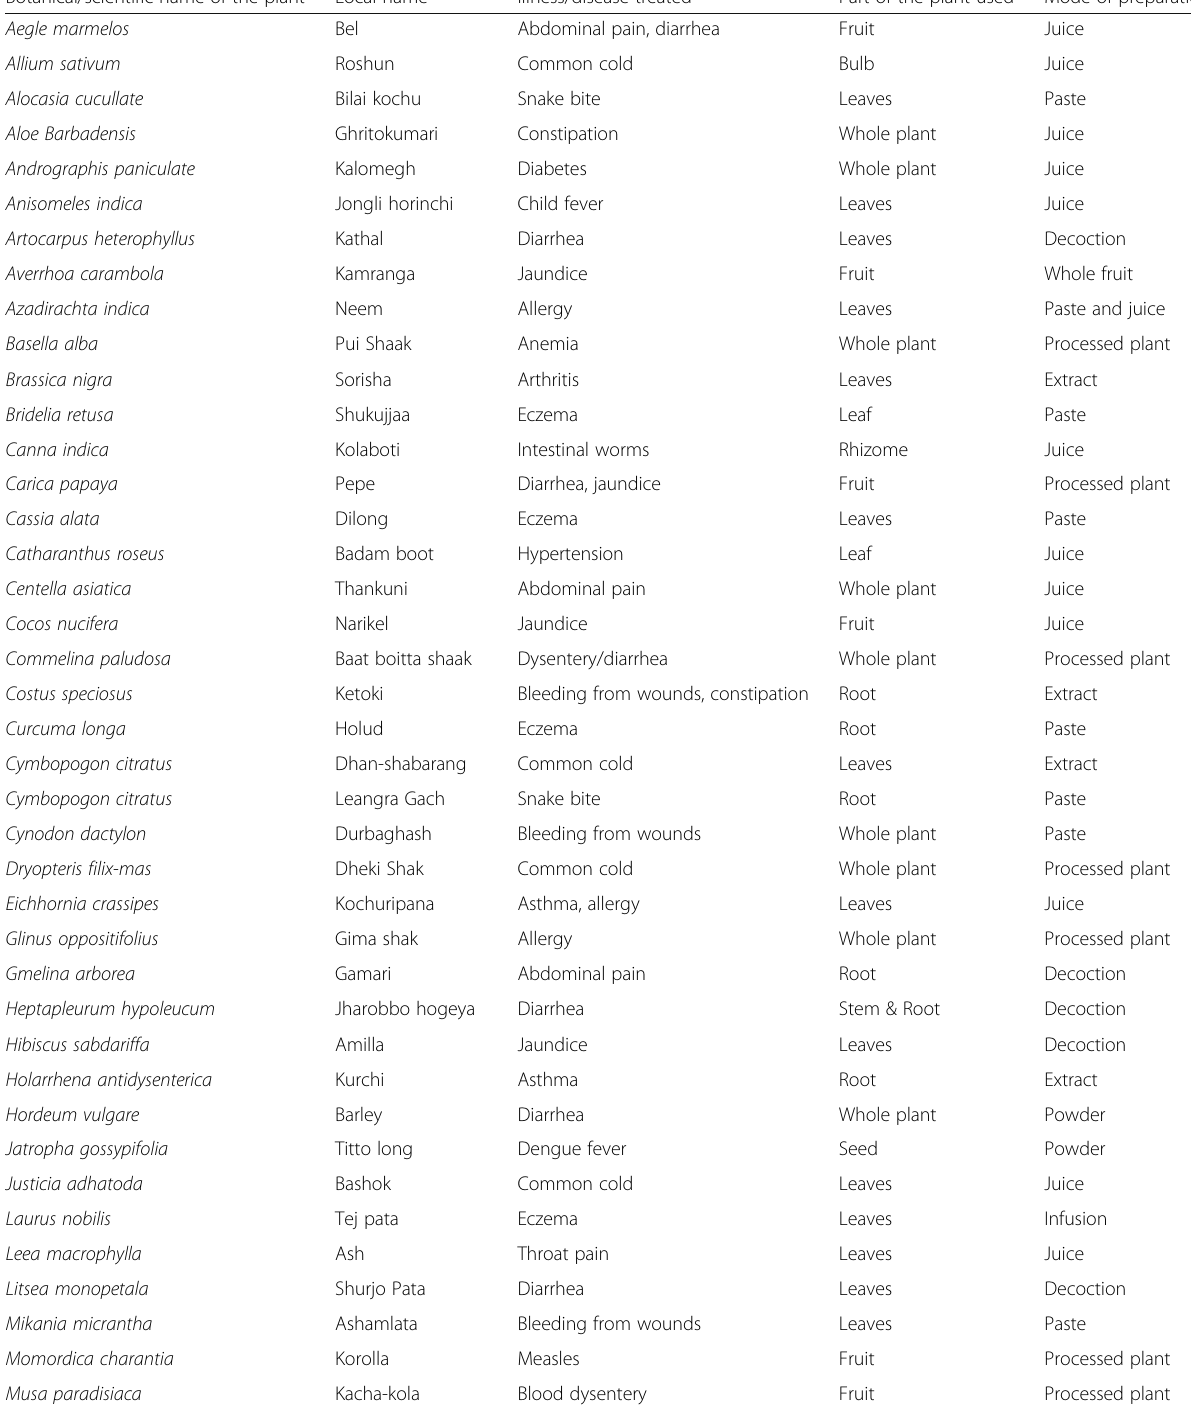
Table 2 Ethnomedicinal plants used by the tribal people of Rangamati for treating different diseases (source: Medicinal Plants Database of Bangladesh [24 – 26]). A total of 62 medicinal plant species were found out of which 26 plants treat gastrointestinal ailments (GIA), 12 plants treat respiratory system disorders (RSD). Poisonous bites (PB) and skeleton muscular system disorders (SMSD) were treated by 2 plants. Endocrinal disorders (ED), throat pain, and hemorrhoids (HEM) were healed by 3 plants. Four plants were used to cure different types of fever (Fvr). For liver problems (LP), 5 plants were used. Dermatological infections/diseases (DID) were treated using 9 different plants. Three plants were used to treat hypertension (HTN) and 2 were used to treat